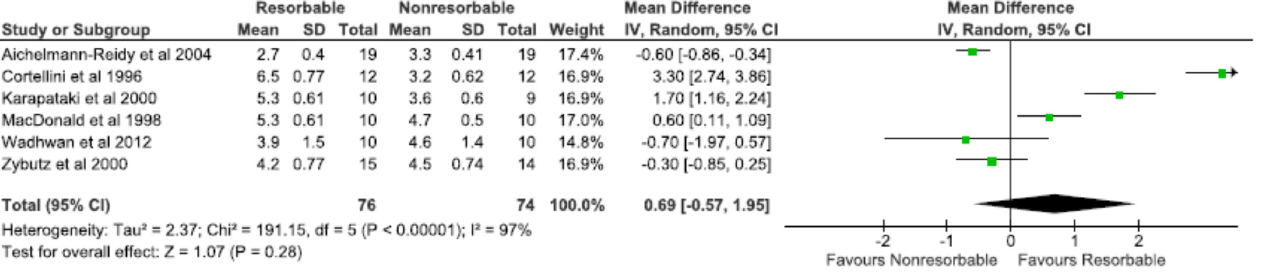
Figure 4. Meta-analysis of probing pocket depth (PPD) at all intervals (6–12